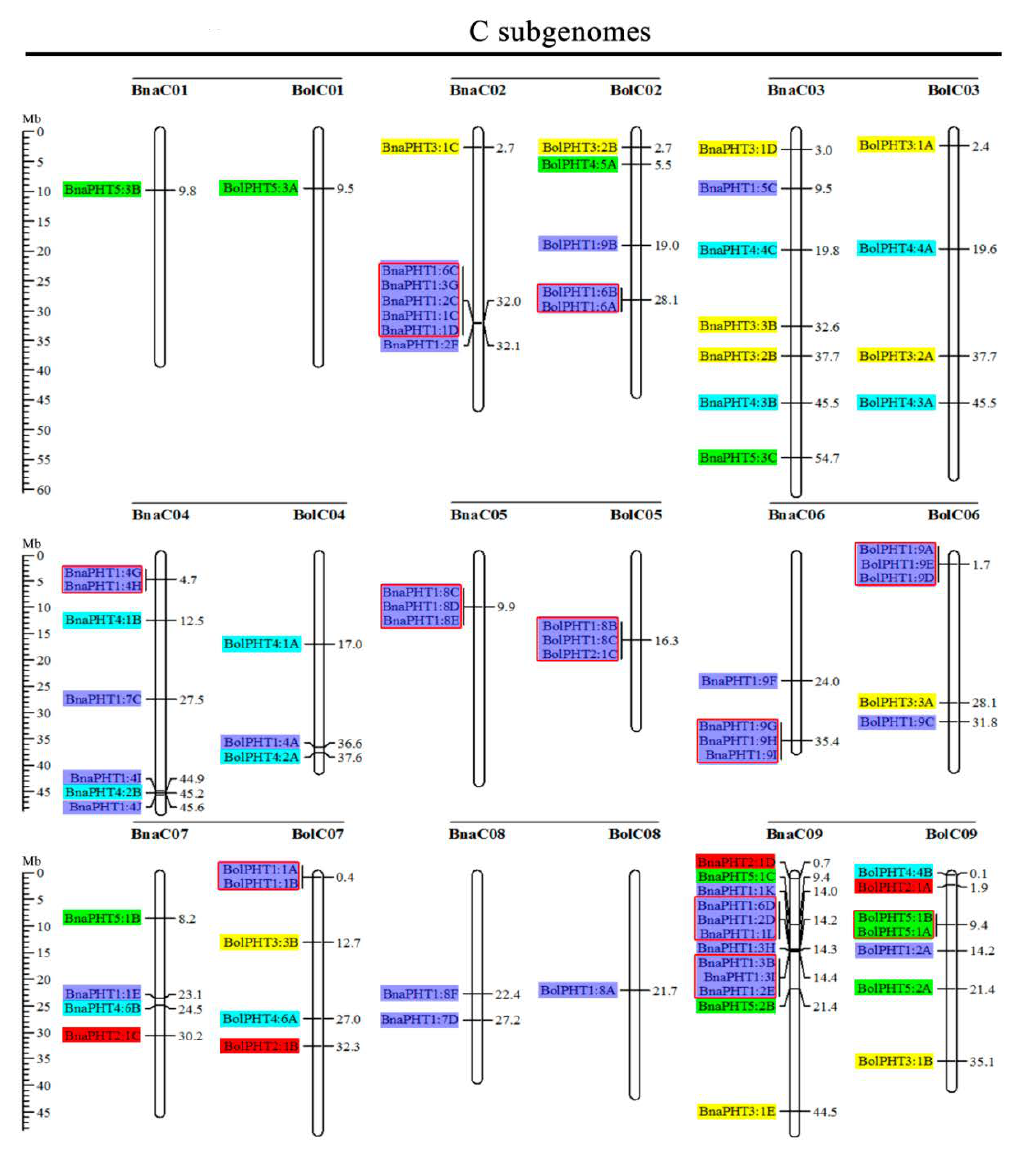
Figure 2. Chromosomal distribution and analysis of duplication events in PHT family genes among Brassica species. Genes from the same subtribe are indicated by the same color, which matches the color used for the corresponding family in the evolutionary tree. The labels on the corresponding chromosomes indicate the names of the source organism and the subgenome. The scales indicate the sizes of various Brassica plant genomes. Any two or more adjacent homologous genes on the same chromosome less than 100 kb apart are highlighted by red boxes. Bra, B. rapa; Bol, B. oleracea; Bni, B. nigra; Bna, B. napus ; and Bju, B. juncea.